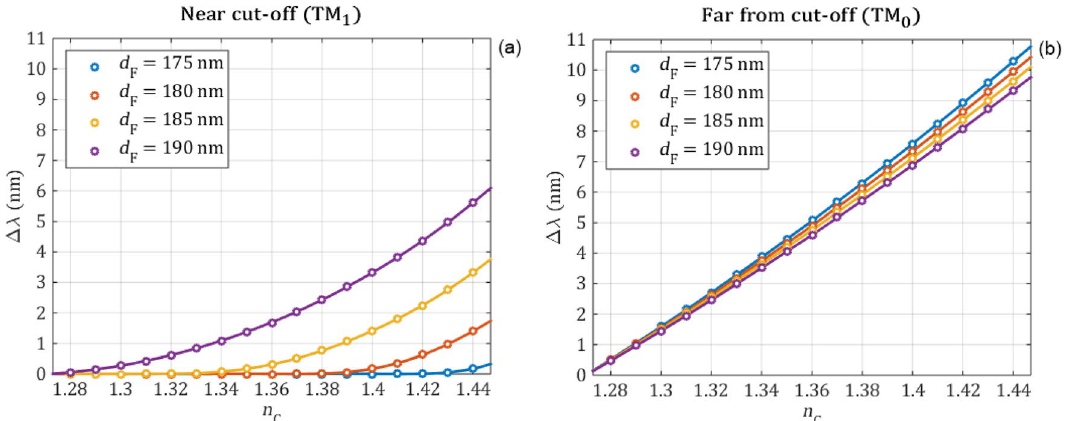
Figure 7. The guided-mode resonance wavelength shifts obtained from full wave electromagnetic simulations (circle markers) are fitted with polynomials (continuous curves) for the near cut-off ( a ) and far-from cut-off ( b ) modes in function of the refractive index of the cover medium for different waveguide film thicknesses. The wavelength shifts are relative to the resonant peak at n C = 1.27 . The wavelength shift is linear in case of the TM 0 mode. However, the wavelength shift of the TM 1 peak becomes less significant approaching the cut-off point.